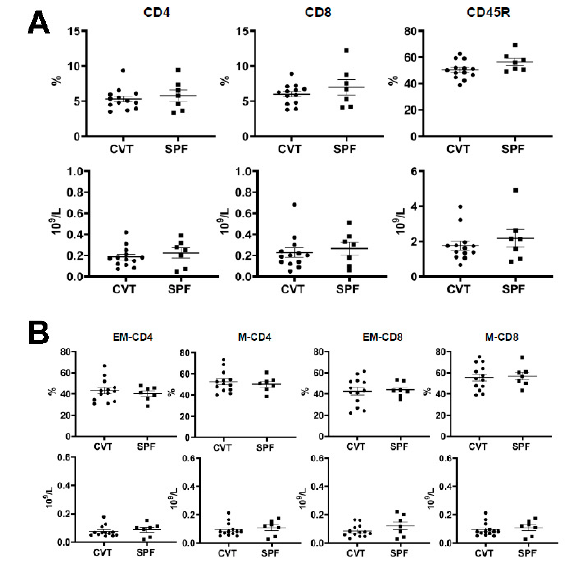
Figure A3. ( A ) B6 mice were maintained in SPF (N = 7) or were transferred to a conventional facility and co-housed (CVT, N = 13)) with mice from that facility for twelve months. Mice were bled at twelve months of co-housing to analyze proportions and absolute numbers of CD4, CD8 and CD45R lymphocytes in peripheral blood. ( B ) CD4 and CD8 T cells were further divided into EM-CD4, M-CD4, EM-CD8 and M-CD8 subsets based on CD44 and CD62L expression in which proportions and absolute numbers of EM-CD4, M-CD4, EM-CD8 and M-CD8 were similar for CVT and SPF mice. Table A1. Differential representation of bacterial strains in fecal samples from CVT and SPF mice. Rank Bacterial Name CVT SPF Main Characteristics 01 Bacteroides mediterraneensis H L G-, anaerobic, rod-shared, isolated in 2016